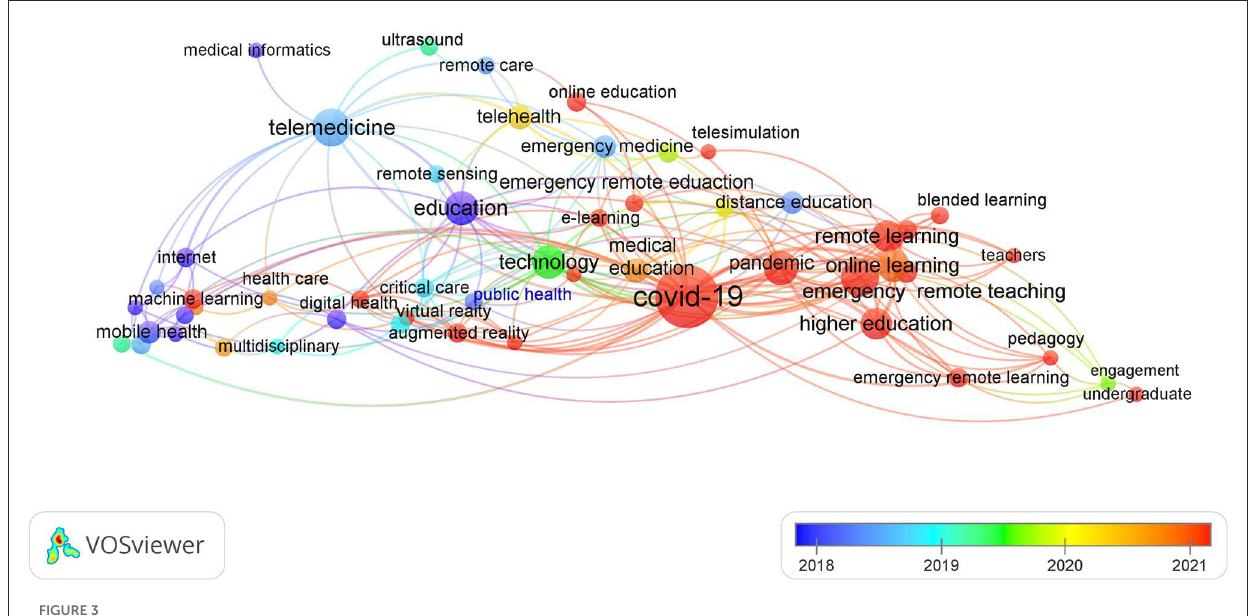
FIGURE3 The variation of the screened keywords changed with